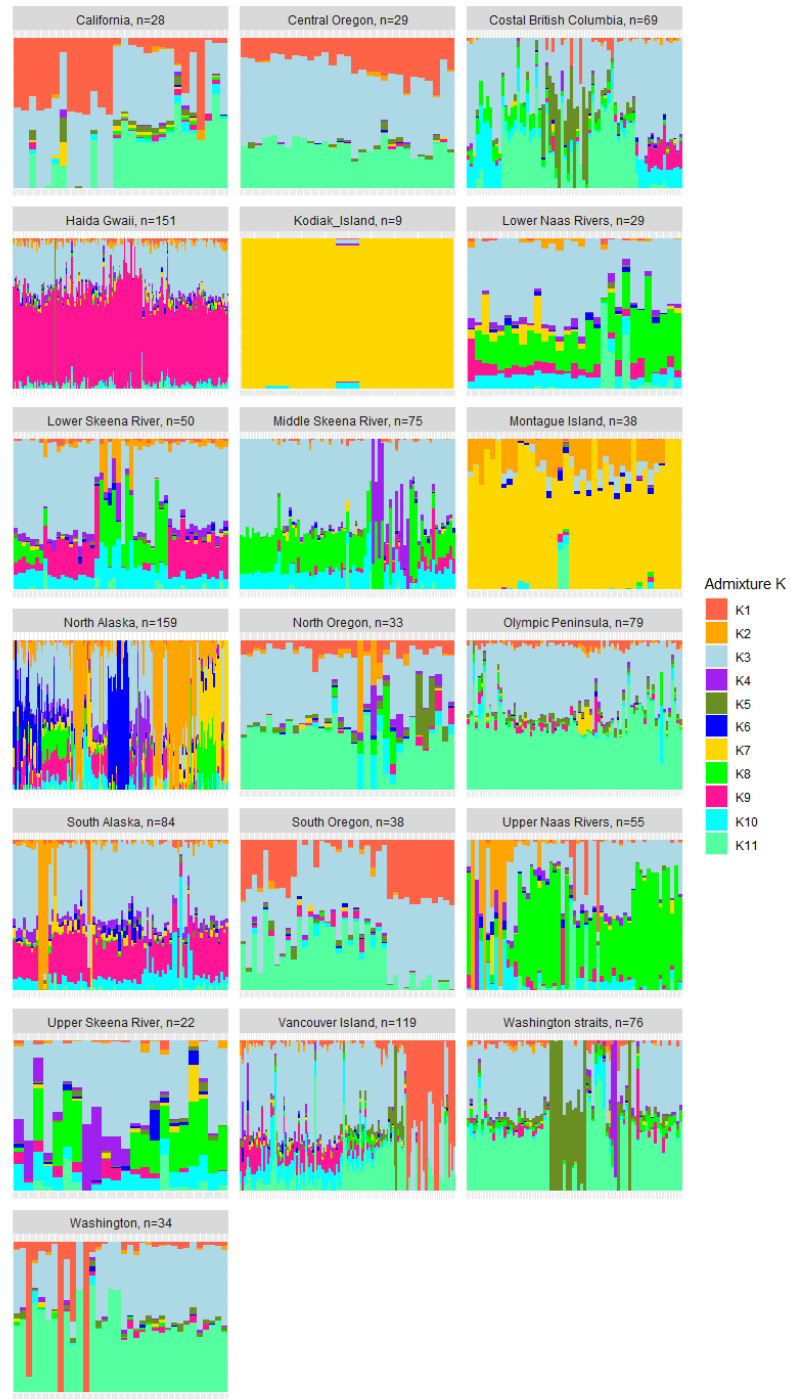
Figure 5. Genetic admixture of all 19 geographic regions of the IUFRO population for 11 ancestral populations. Optimal K (ancestral populations) for admixture is 11 based on 10 replicates of K 2-50, using a cross-validation method. Each geographic region is represented here, showing the ancestral makeup of the